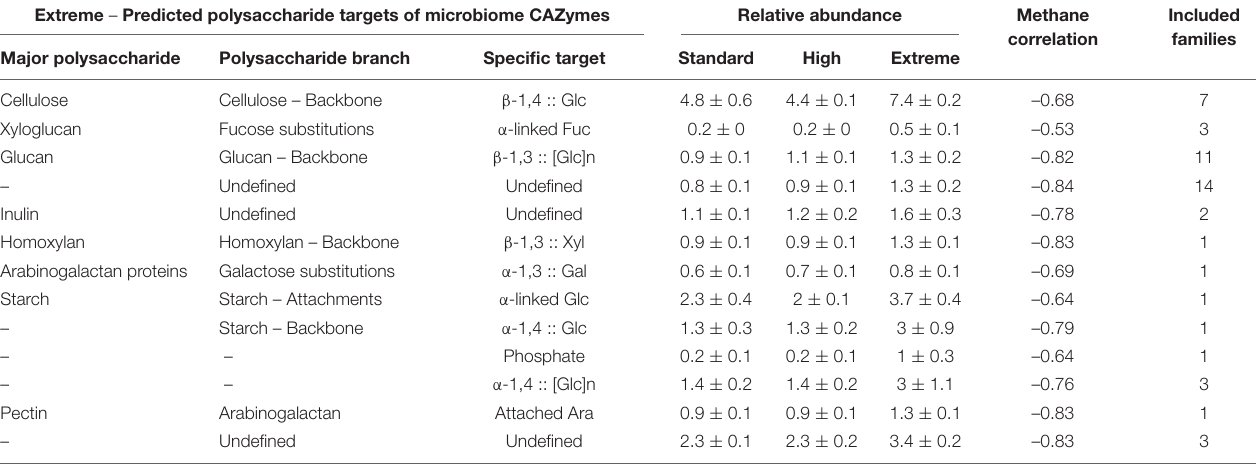
The functions of all the CAZy families add up to 84 substrate linkage targets, of which the 28 included had a significant change between the Standard and the Extreme groups (t-test with a p-value below 0.05 and least 20% change). The column methane correlation is Spearman rank correlation between the abundance of the given linkage target and the methane emission from the cows.